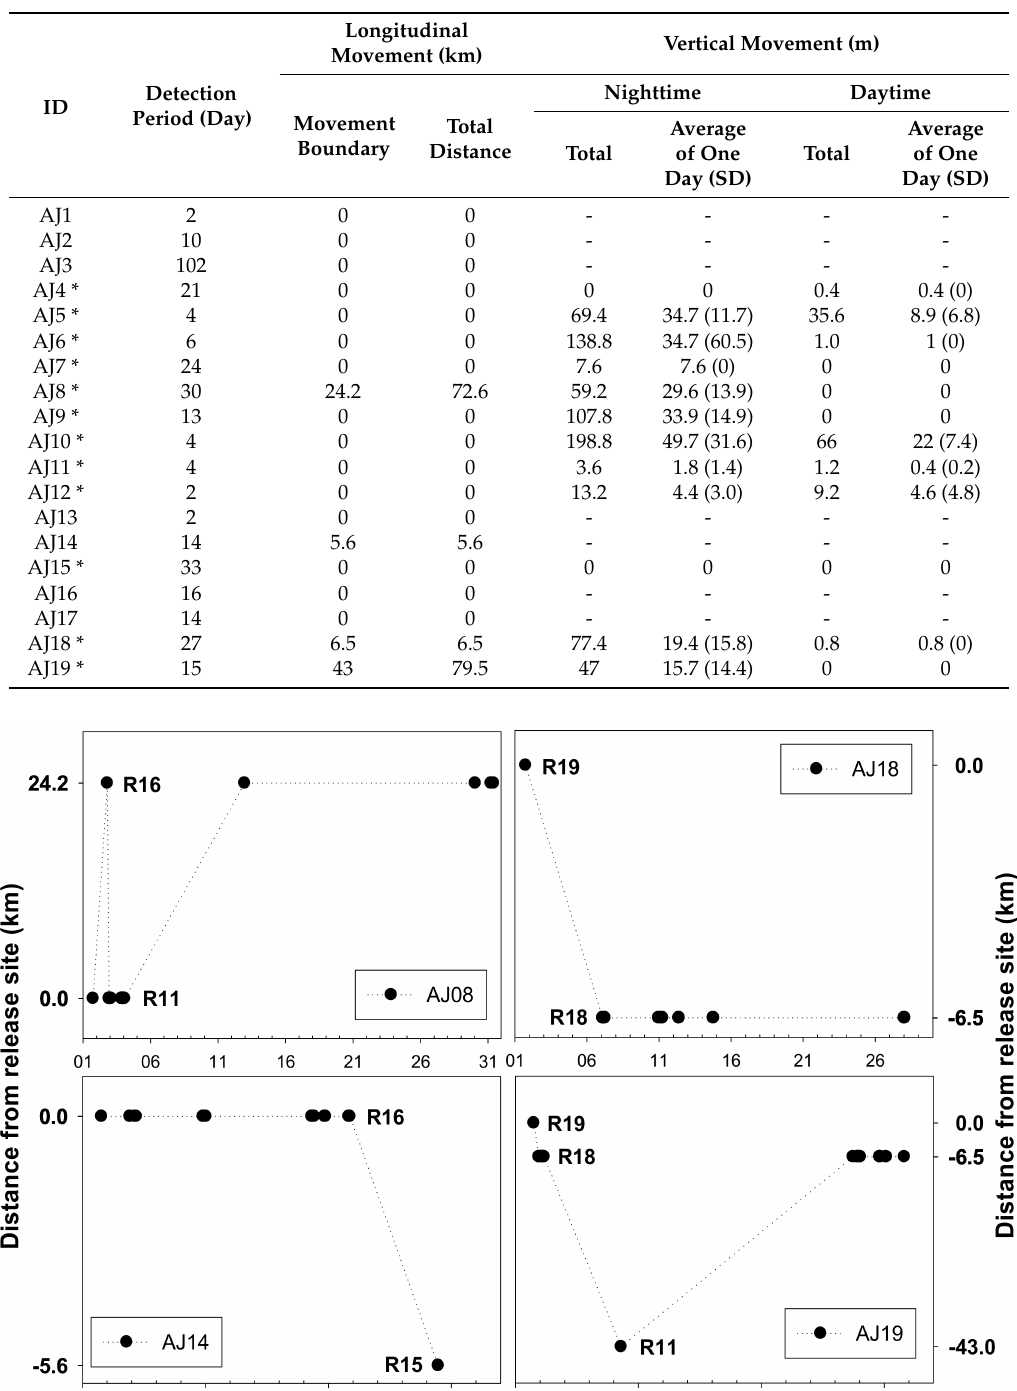
Table 2. Longitudinal and vertical movement distances of A. japonica (*, depth sensor; SD, standard deviation). Vertical movement distance is the sum of distances between each detection point.